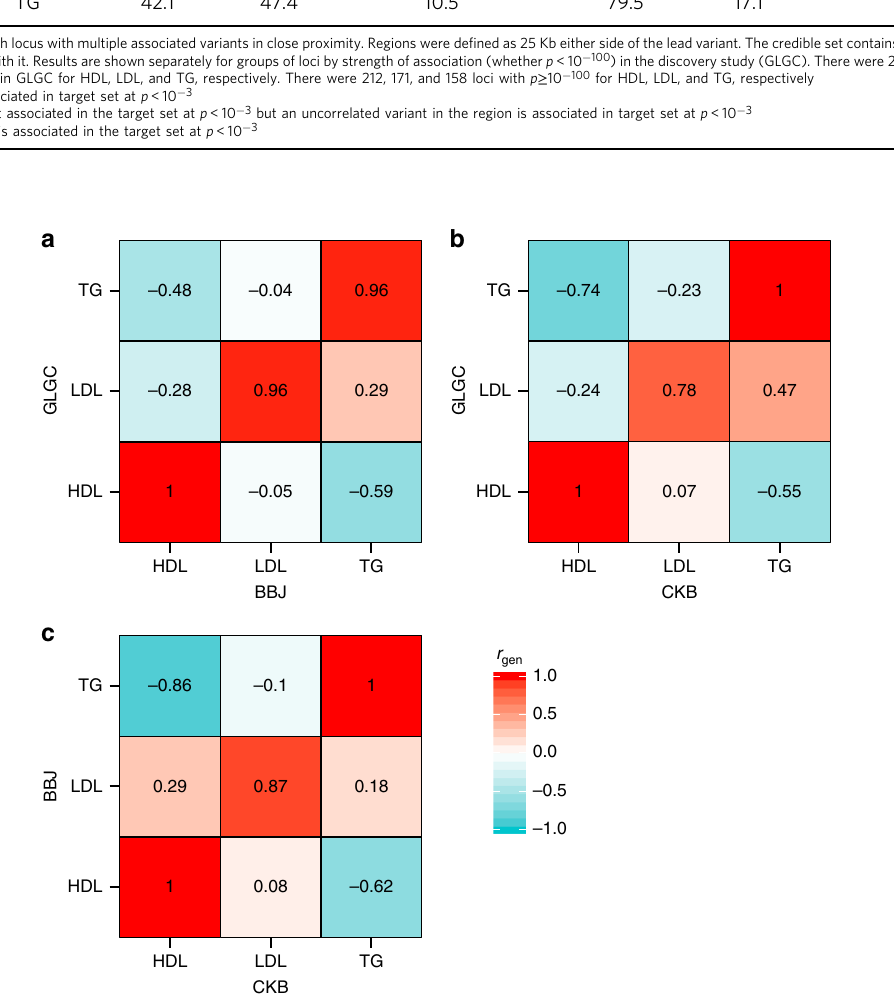
Fig. 1). The power to detect shared associations for betas of 0.25